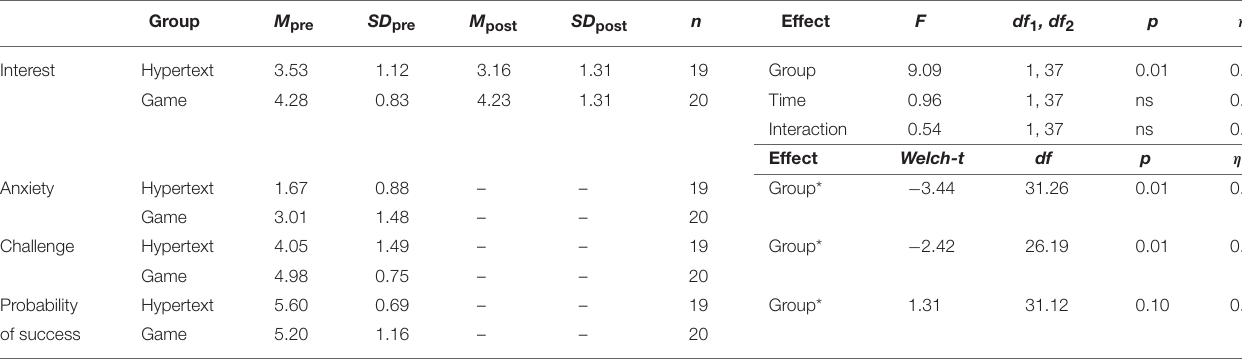
TABLE 4 | Descriptive statistics and the test results of the four motivation